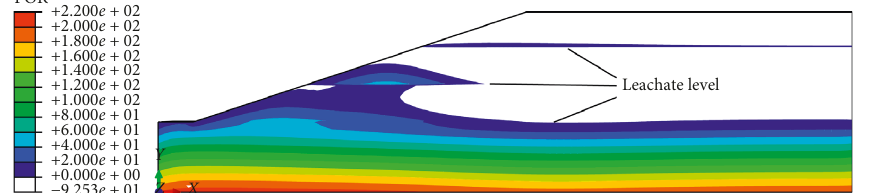
Figure 17: Leachate level in Scheme 1 ( t � 4h).